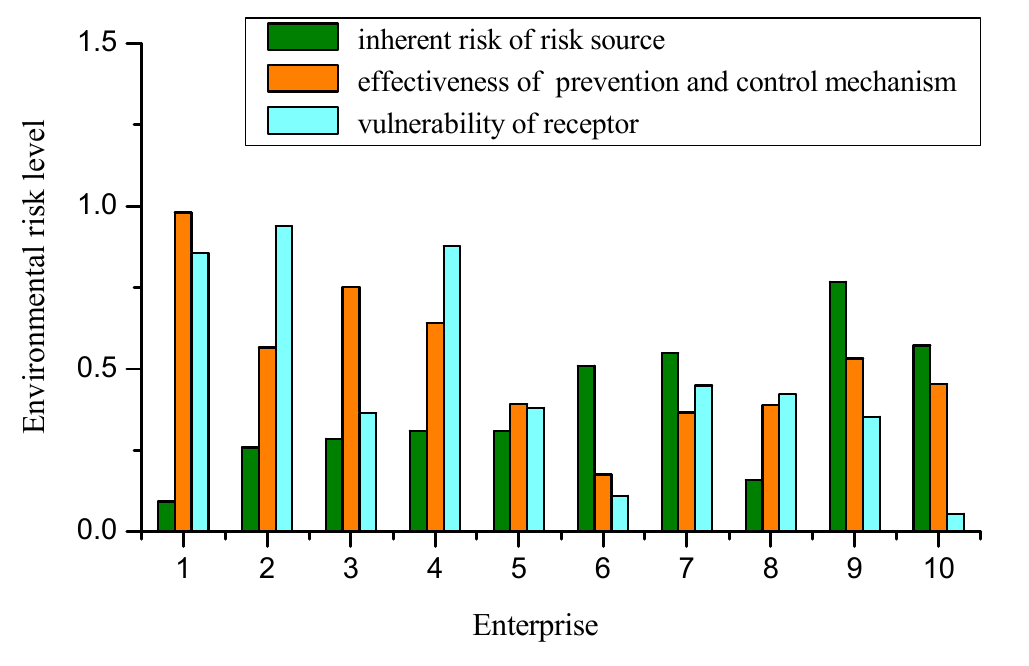
Figure 4. Risk levels of layer B indices of chemical enterprises in Songmu Island Chemical Industrial